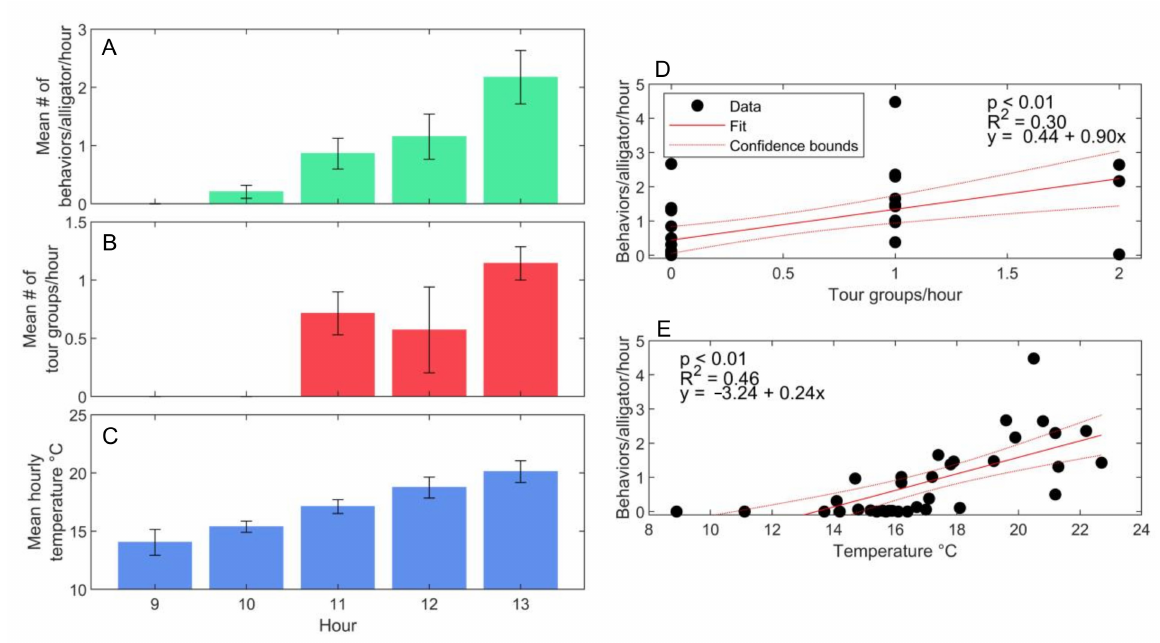
Figure 8. A comparison of trends in behavior, human interactions, and temperature by hour in the captive congregation. ( A ) The mean ( ± SE) number of behaviors (including social and general) divided by group size per hour by hour of day. ( B ) The mean ( ± SE) number of tour groups per hour by hour of day. ( C ) The mean ( ± SE) hourly temperature ( ◦ C) by hour of day. ( D ) Relationship between the frequency of alligator behavior compared to the frequency of tour groups. The solid line represents a fitted linear model with the dashed lines representing the 95% confidence interval. ( E ) Relationship between the frequency of alligator behavior compared to the air temperature. The solid line represents a fitted linear model, with the dashed lines representing the 95% confidence